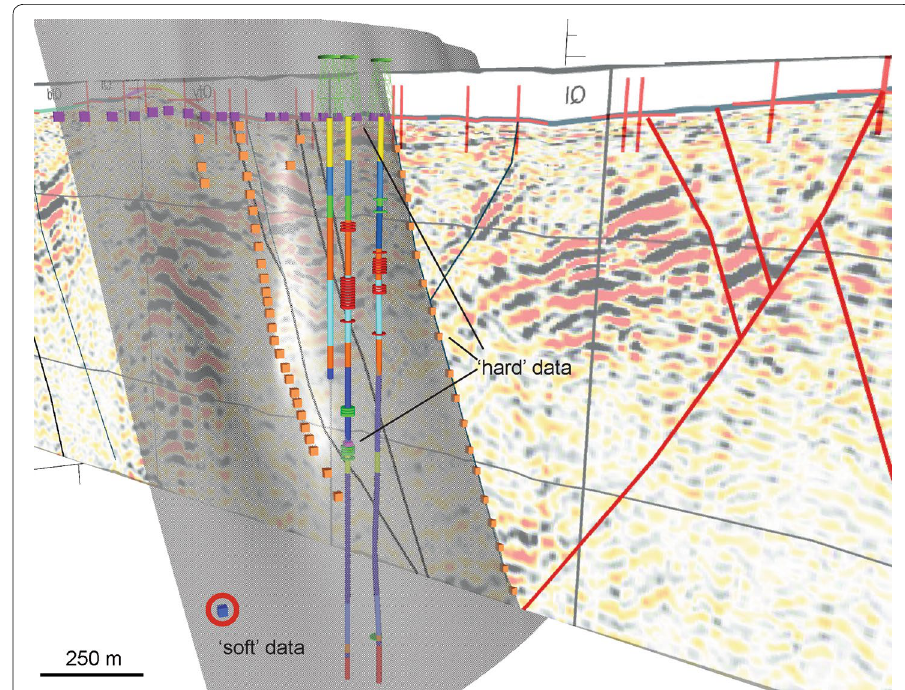
Fig. 5 3D fault mapping. This example shows the process of interpreting and digitizing one fault from Astor Pass (Siler et al. 2016a). Seismic reflection interpretation (orange cubes), the occurrence of fault gouge/ slickenlines in cuttings, losses of circulation during drilling (green and red discs on the well paths), and geologic map data (purple cubes at the surface) are ‘hard’ data that control the geometry of the 3D fault surface (gray, transparent). ‘Soft’ data (blue cube) constrains the fault geometry distal to the hard data, such that strike and dip remain consistent with the hard data along the entire length of the